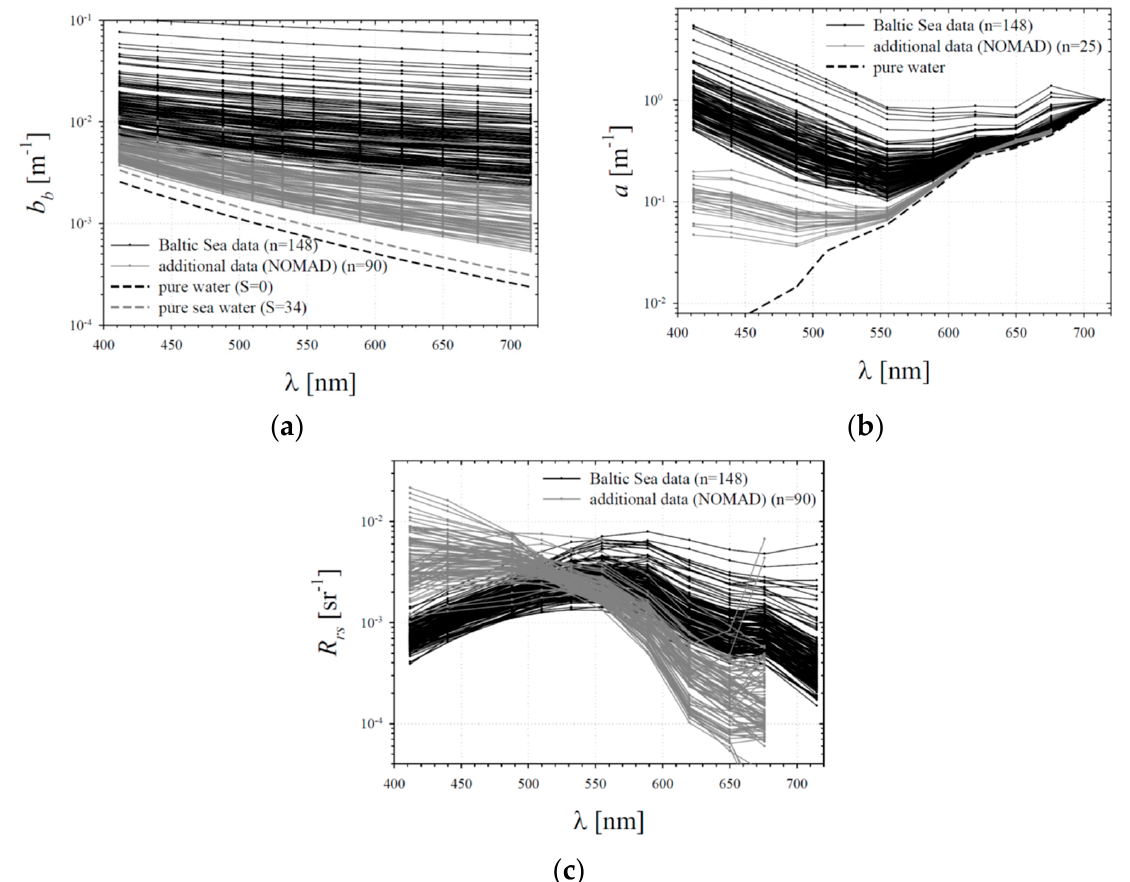
Figure 4. Empirical data analysed in this work: ( a ) spectra of the backscattering coefficient; ( b ) absorption coefficient; ( c ) remote-sensing reflectance. The authors’ original data from the Baltic Sea are shown as black curves; additional data from the NOMAD database are plotted in grey. Values representing pure water are plotted in panels a and b.